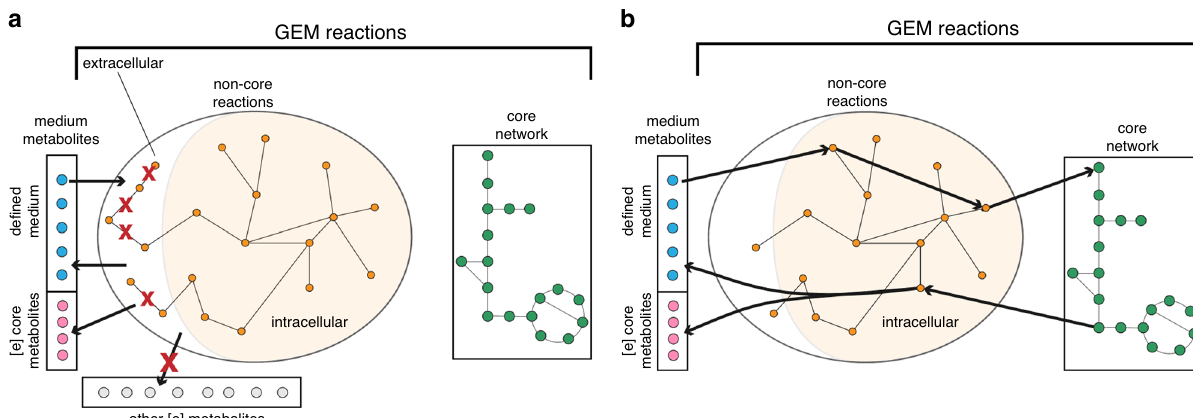
Fig. 6 redGEMX method. a Classi fi cation of the reactions from the GEM into core (green) and non-core reactions (orange), and classi fi cation of the extracellular metabolites from the GEM into those that are part of the medium that we want to connect (blue), those that are present in the core (pink), and the others (gray). The algorithm will block the non-core reactions that involve only extracellular metabolites as well as the boundary and transport reactions of the metabolites that are not part of the medium (gray). b The algorithm fi nds the minimal set of reactions that are required to connect each of the medium metabolites (blue) to the core network, uses the core network to balance the reactions, and secretes metabolites from the medium (blue or